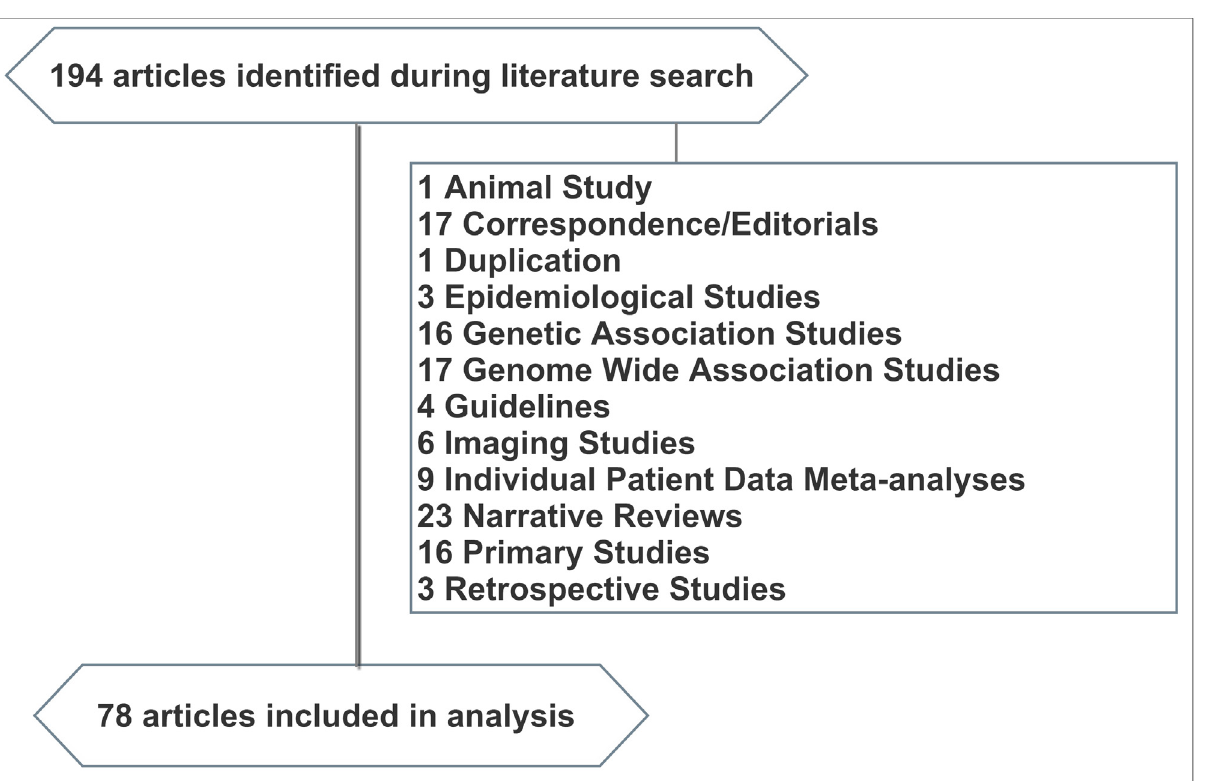
Fig 1. Flow diagram of Study